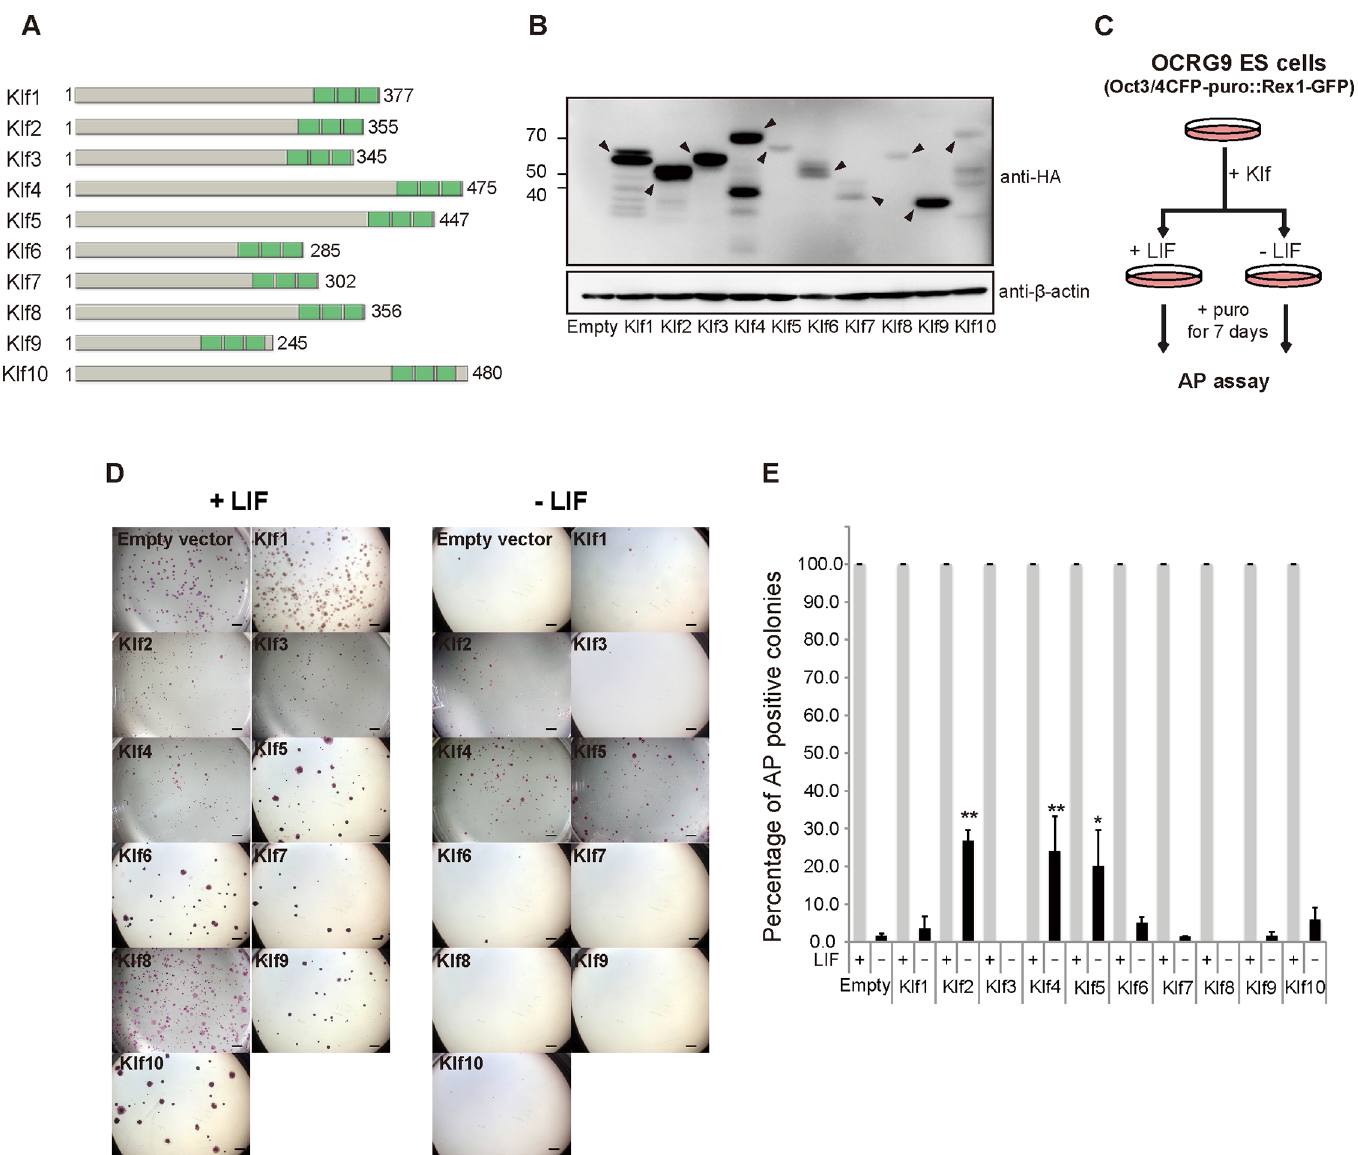
Fig 1. Comprehensive identification of Krüppel-like factor ( Klf ) family members whose overexpression achieves leukemia inhibitory factor (LIF)- independent self-renewal of mouse embryonic stem (ES) cells. (A) A schematic representation of Klfs. These proteins have highly homologous C- terminal DNA binding domains characterized by three C 2 H 2 zinc finger motifs, shown in green boxes. The number of amino acids is shown to the left. (B) Western blot of proteins from mouse ES cells overexpressing FLAG-HA epitope-tagged Klf. Anti-HA and anti- β -actin antibodies were used to detect HA- tagged Klf and endogenous β -actin, respectively. Arrowheads indicate HA-tagged Klf proteins. (C) A schematic illustration of the experimental outline to assay the ability of a Klf protein to maintain self-renewal. (D) Generation of colonies from ES cells carrying either the empty vector or a Klf expression vector in the presence or absence of LIF. Scale bar: 2 mm. (E) The percentage of AP-positive colonies. Asterisks indicate statistical significance. * P < 0.05; ** P <